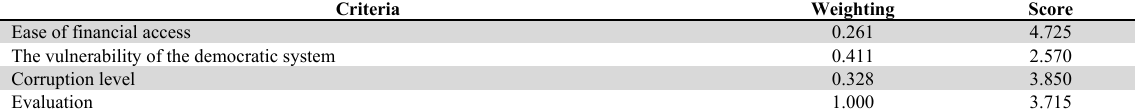
The weighting of Social Vulnerability Variables of Law and Regulation Criteria